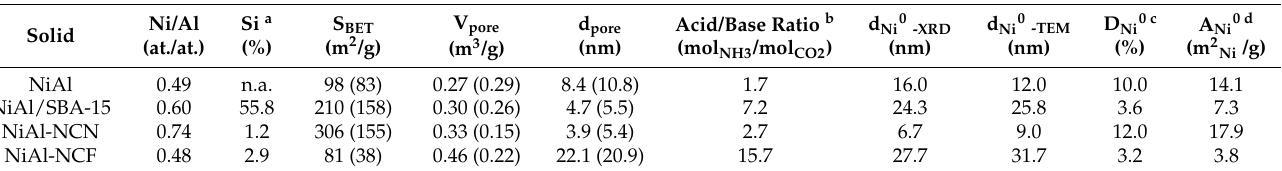
Figure 1. N 2 adsorption − desorption isotherms and pore size distributions in the calcined and reduced forms of catalysts. Table 1. Bulk chemical composition, textural and acid/base properties and crystallite sizes of Ni 0 and exposed metallic surface.